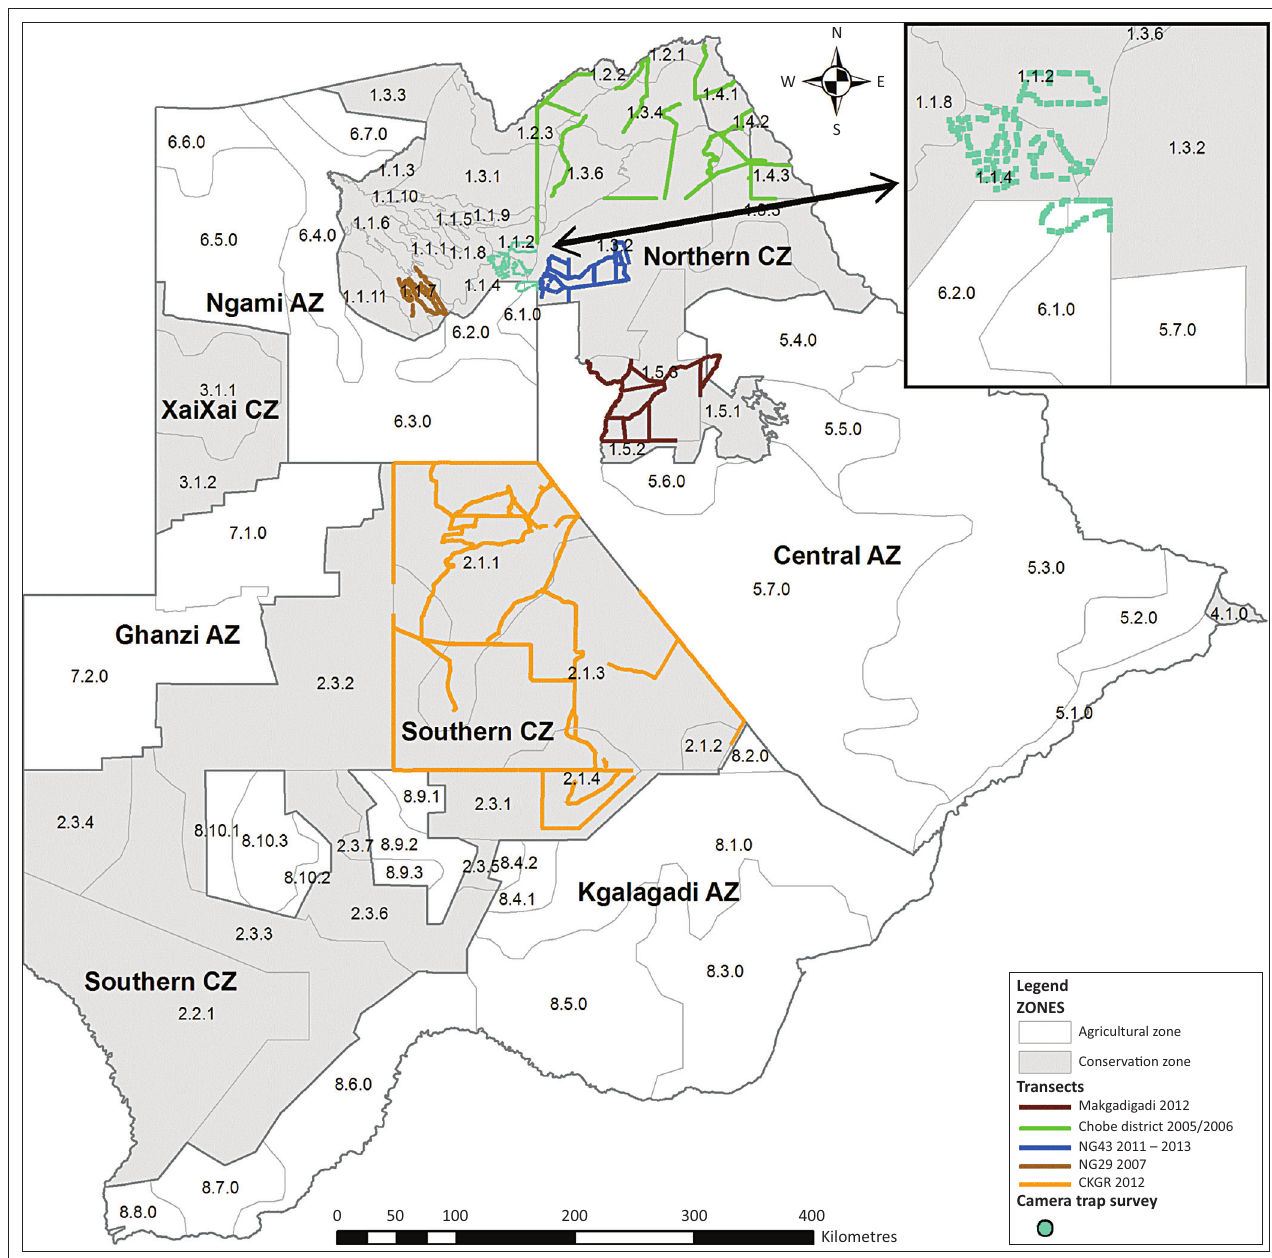
FIGURE 2: Stratification of Botswana and locations of track surveys and camera trap survey (detail on inset) conducted between 2005 and 2015 to estimate brown hyaena ( Parahyaena brunnea )